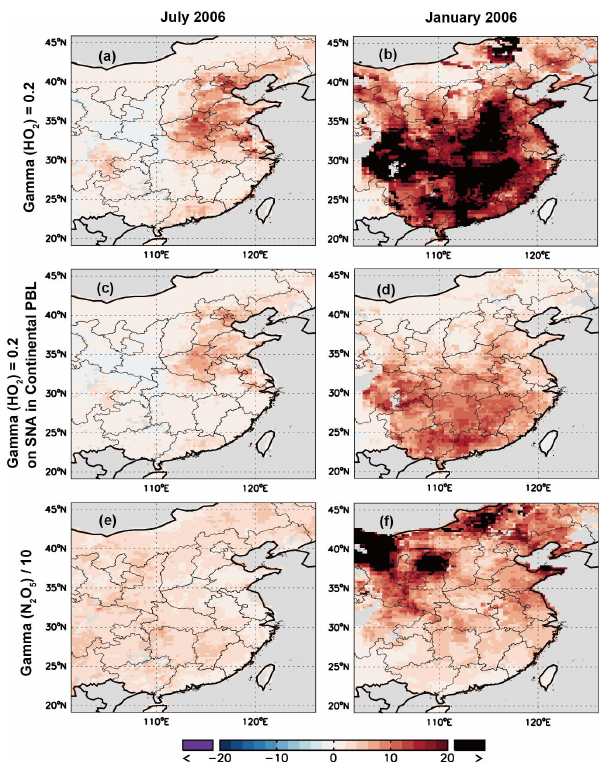
Fig. 10. Spatial distribution of percentage differences between mod- eled NO 2 columns with and without adjustments in the heteroge- neous chemistry. (a, b) The uptake rate of HO 2 on aerosols is as- sumed to be 0.2. (c, d) The uptake rate of HO 2 on sulfate-nitrate- ammonium aerosols is assumed to be 0.2 in the continental bound- ary layer. (e, f) The uptake rate of N 2 O 5 on aerosols is scaled down by a factor of